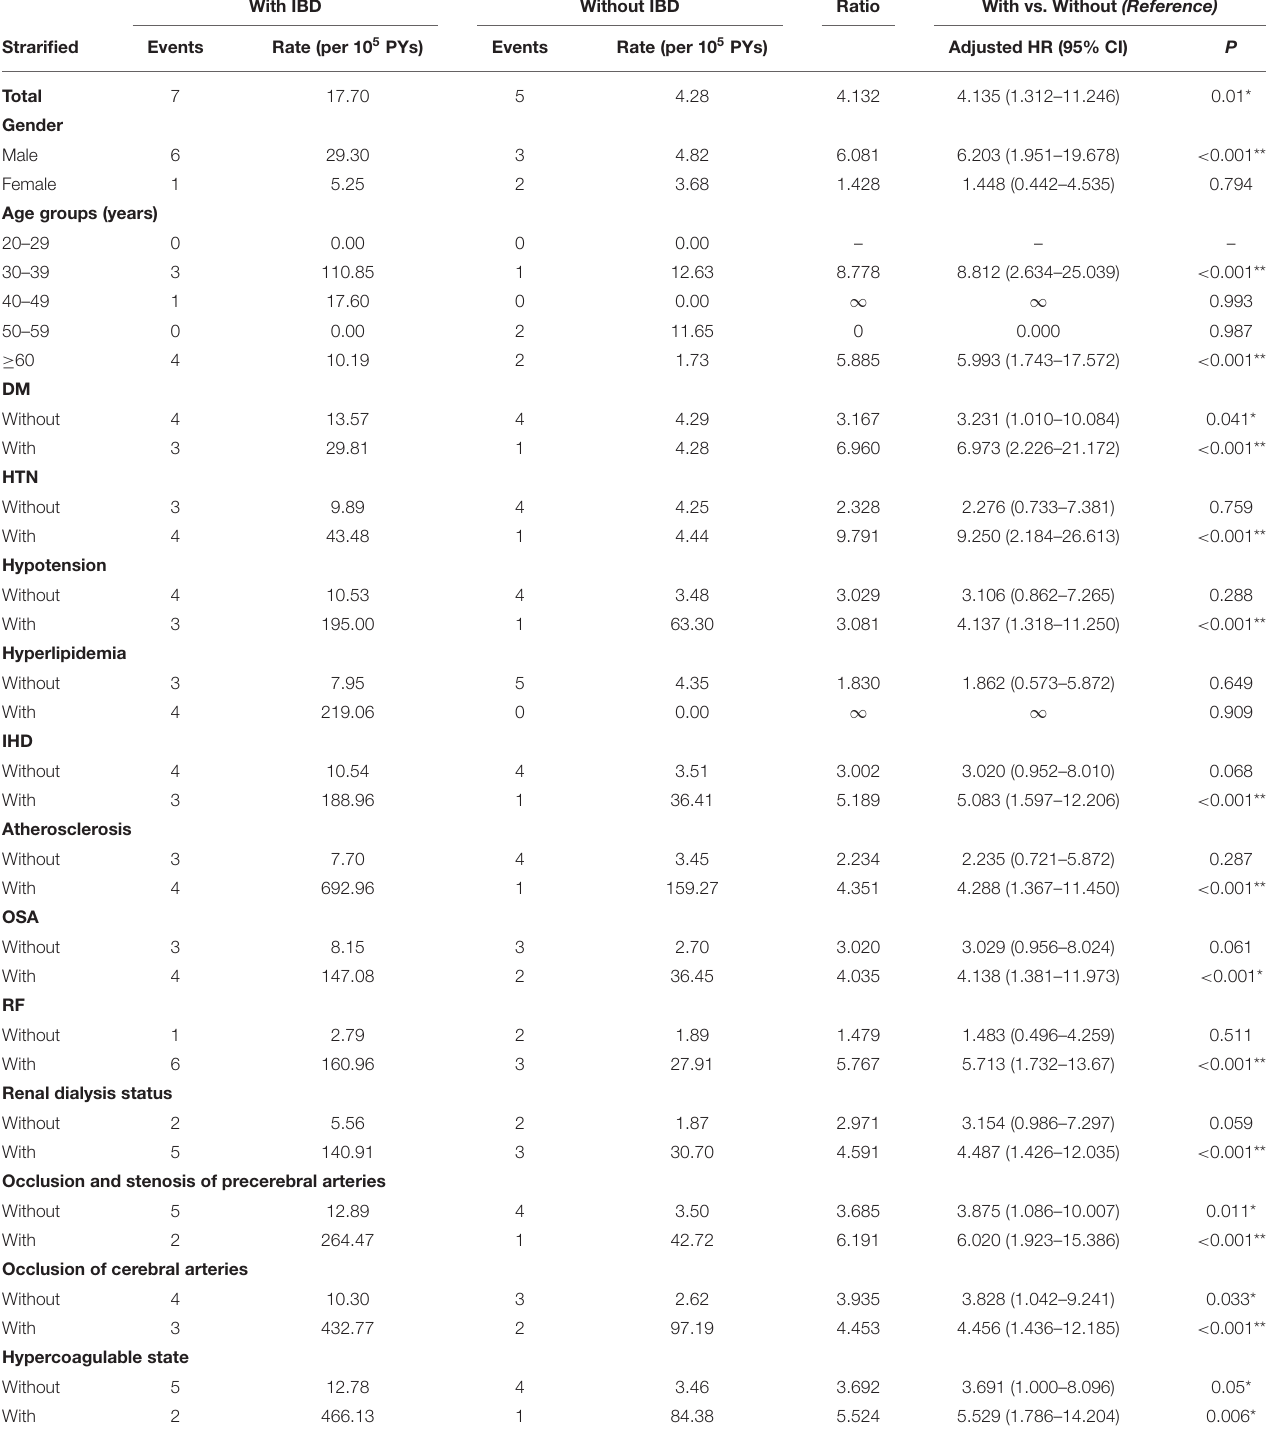
TABLE 3 | Risk analysis for ischemic optic neuropathy stratified by demographic and clinical characteristics between patients with/without IBD. With IBD Without IBD Ratio With vs. Without